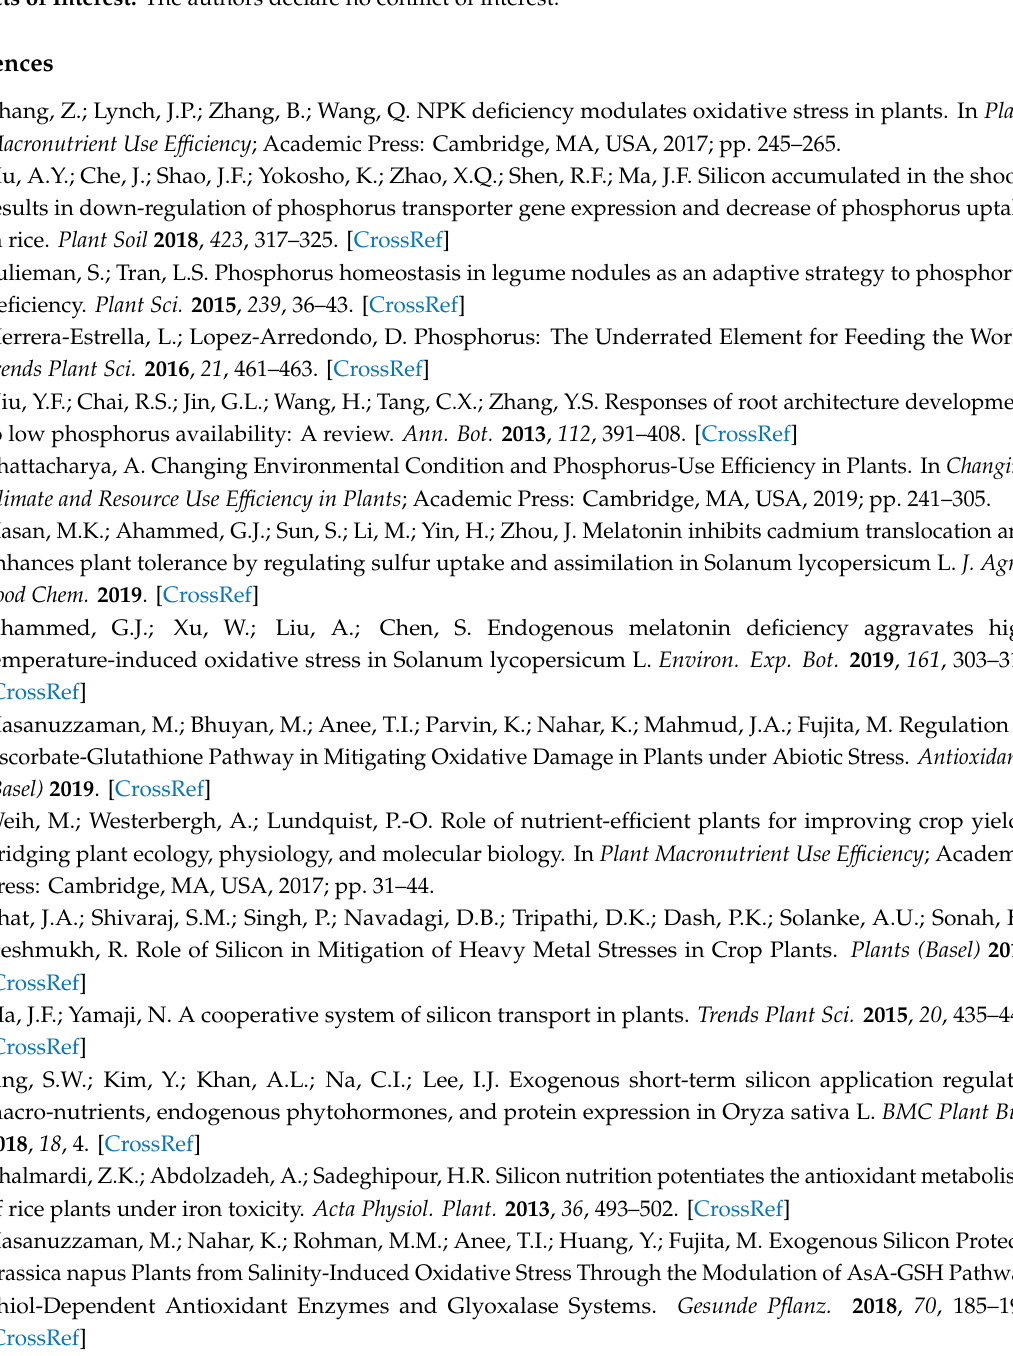
Supplementary Figure S1. E ff ect of di ff erent concentrations of phosphorus (P) and silicon (Si) on lipid peroxidation measured as malondialdehyde (MDA) content in tomato leaves and roots. Supplementary Figure S2. Shoot phenotype of tomato plants as influenced by low phosphorus (LP) and silicon (Si)